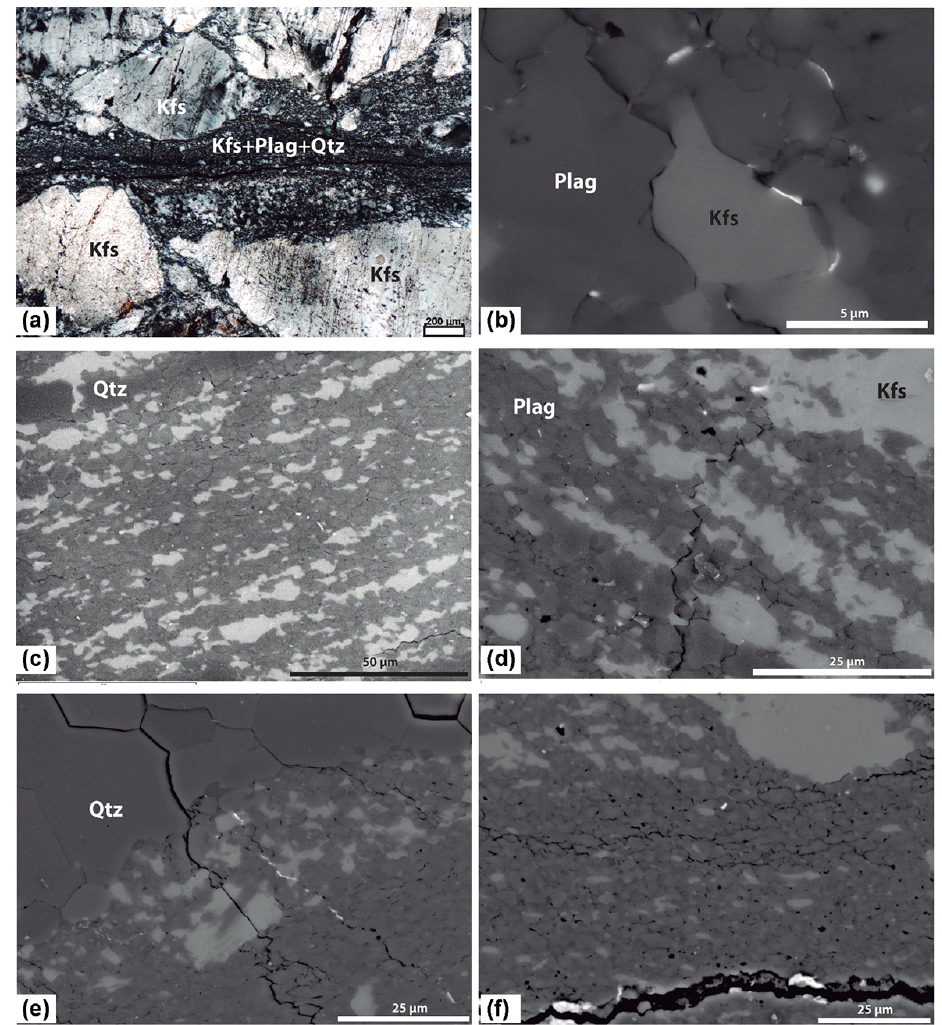
Figure 6. Optical and SEM microstructures of the C’ shear bands. (a) Optical micrograph of a C’ band showing its boundaries with feldspar porphyroclasts; quartz ribbons are embedded in the band. (b) Boundary geometry of fine-grained K-feldspar and plagioclase grains in the matrix. (c–f) Details of the fine-grained feldspathic mixture in the C’ bands. Overall grain size is